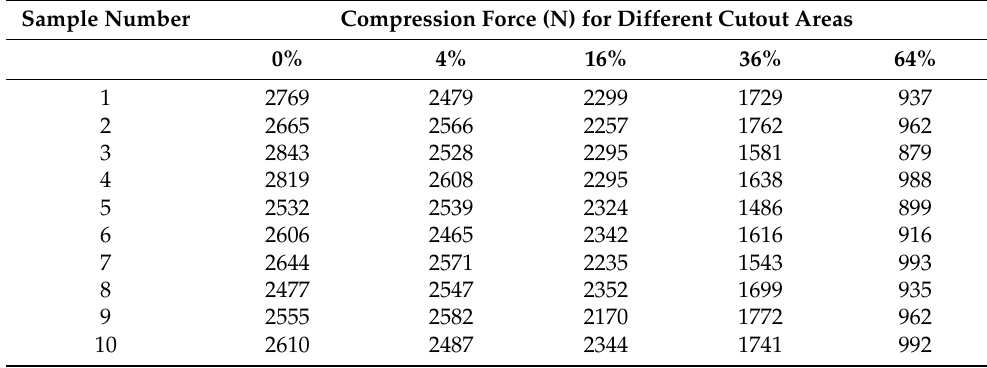
Figure 4. BCT curves: ( a ) with 0% cutout, ( b ) 4% cutout, ( c ) 16% cutout, ( d ) 36% cutout, and ( e ) with 64% cutout (10 samples for box size of 400 × 300 × 300 mm). Table 3. BCT (N) values of 10 measurements for different cutouts (400 × 300 × 300